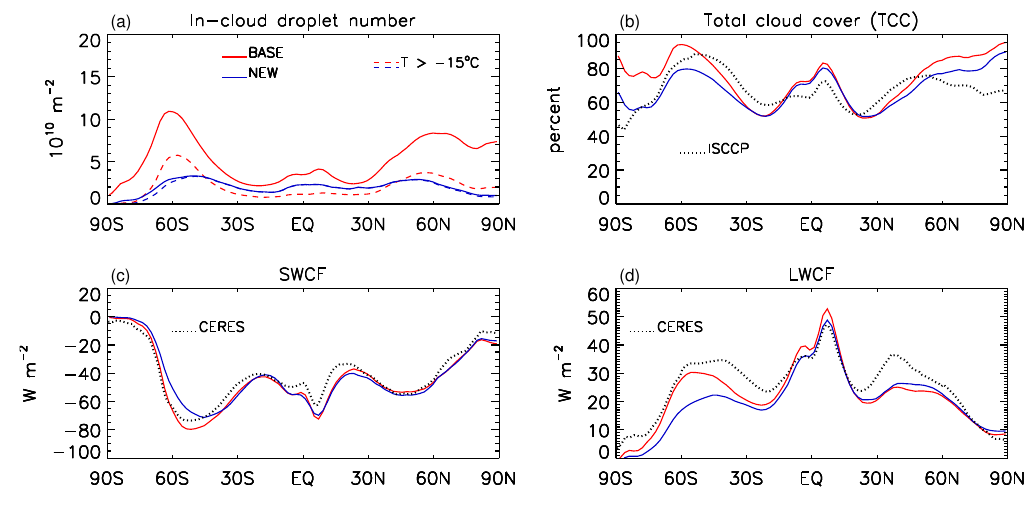
Fig. 3. As Fig. 2. Column integrated zonal mean in-cloud droplet numbers in (a) are for the entire vertical domain (solid lines) and for temperatures above − 15 ◦ C only (dashed